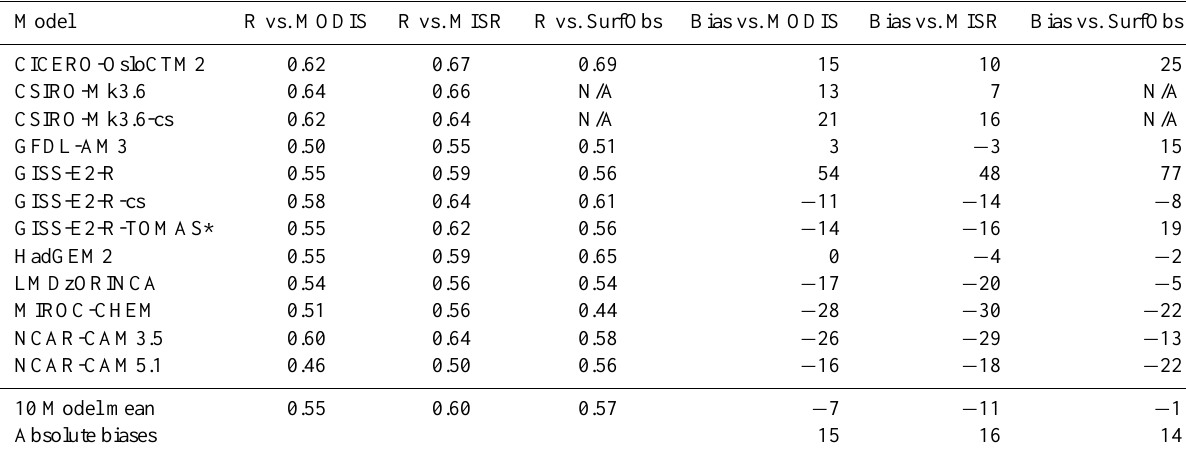
Table 2. Monthly mean AOD (550nm) compared with observations. Model R vs. MODIS R vs. MISR R vs.